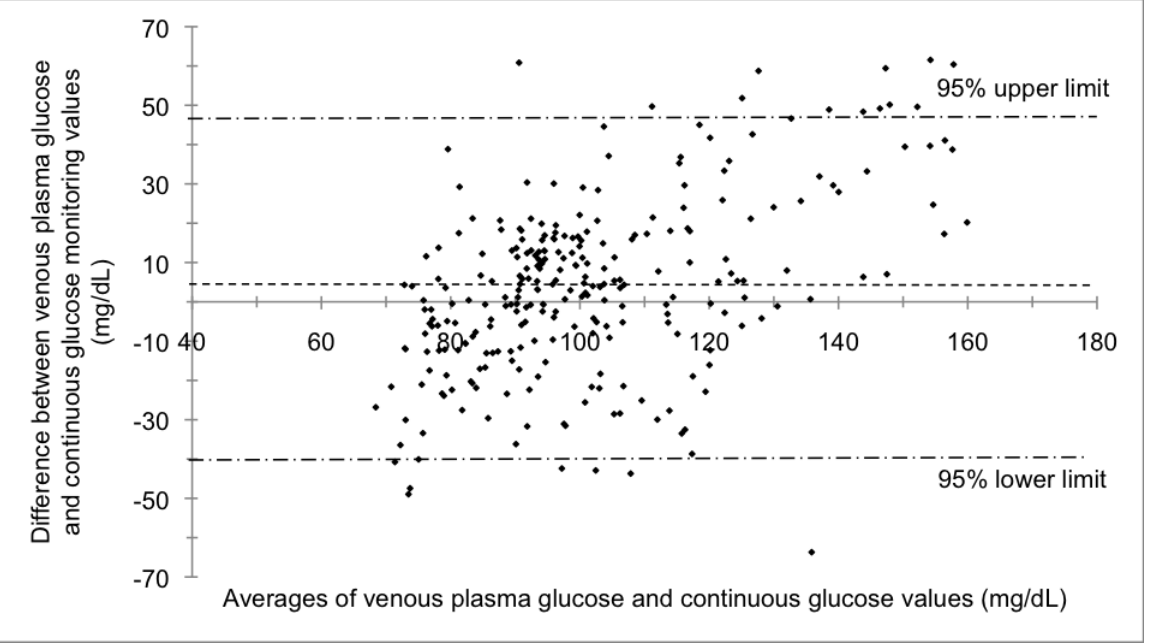
Figure 2. Limits of agreement between venous plasma glucose and continuous glucose monitoring-estimated values during 45 min of steady-state moderate-intensity cycling and 15 min of recovery ( r = 0.5) performed by healthy females in a study to determine the comparability of three glucose monitoring methods. 4.4% of values outside the limits of agreement fell above the upper